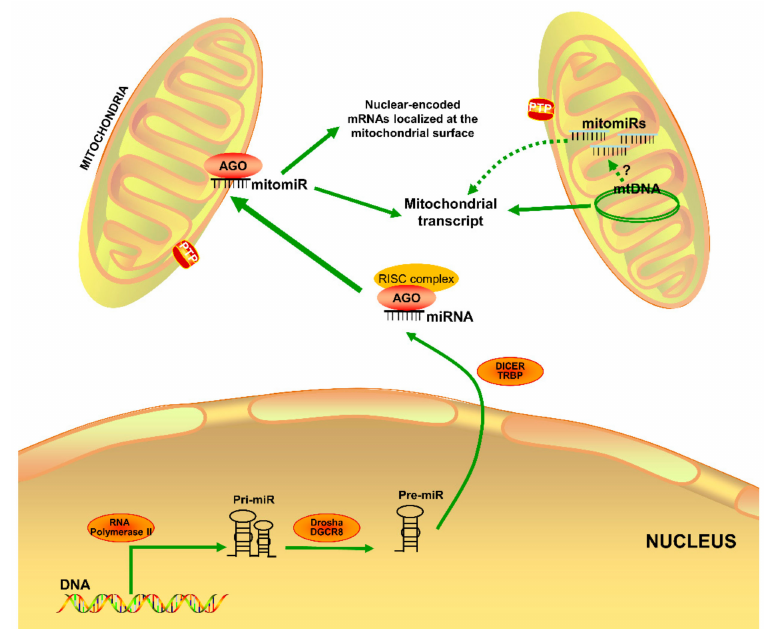
Figure 1. Illustration of mitomiR origin and functioning site in the cell. Some mature miRNAs are imported into mitochondria after the pre-miRNA originated from the nucleus are processed by DICER. The other mitomiRs may be originated from mitochondrial genome-derived mRNA molecules. All mitomiRs can exert post-transcriptional modification in the mitochondria. Imported miRNAs may also target and function at nuclear-encoded mRNAs localized on the mitochondrial surface. However, the mechanisms underlying mitomiRs biogenesis and action site are still poorly